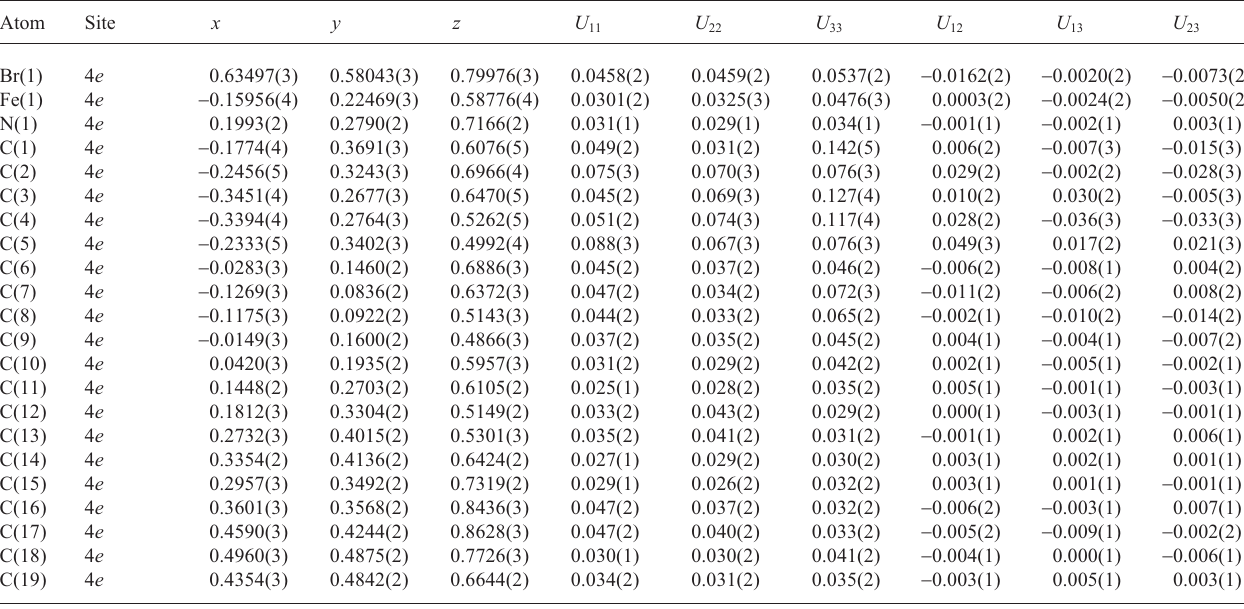
Table 3. Atomic coordinates and displacement parameters (in Å 2 )